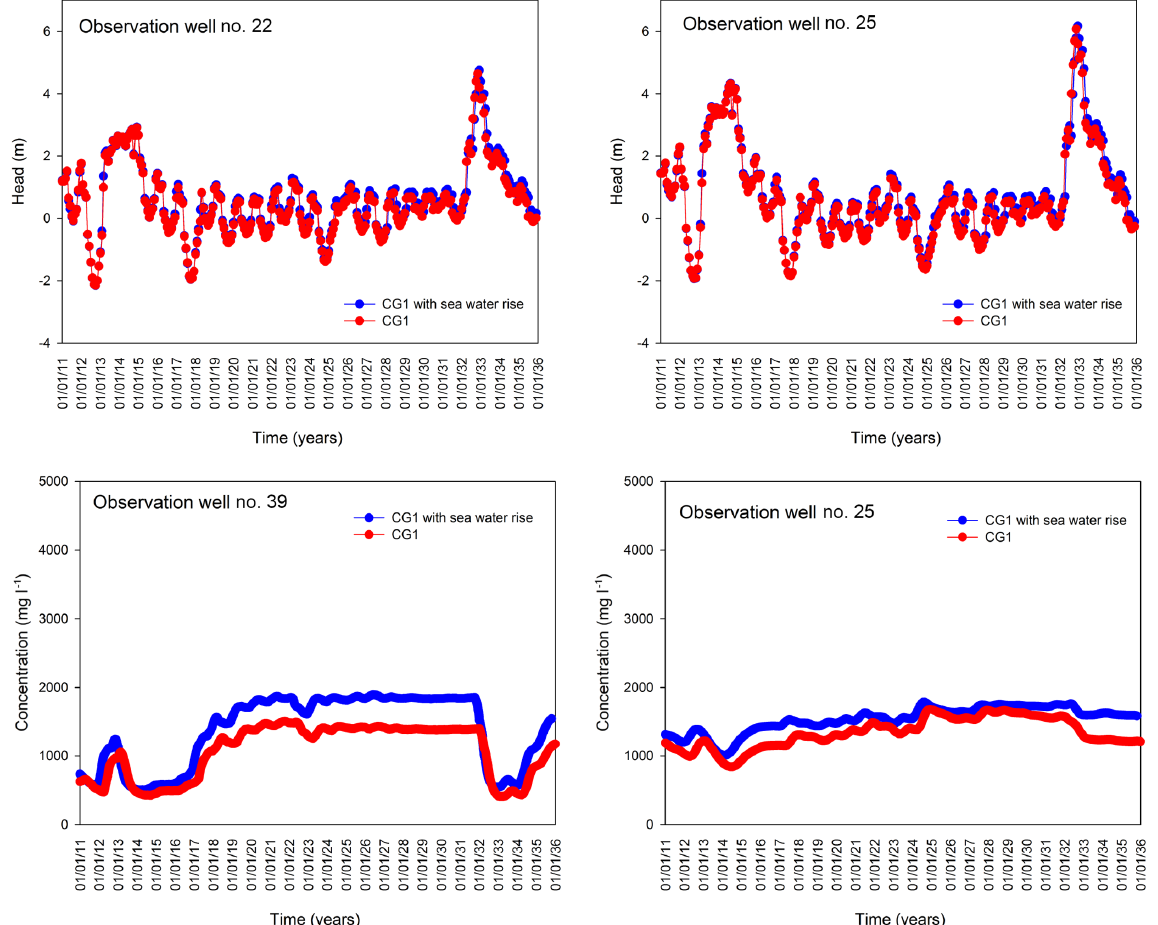
Figure 15. Sensitivity of head and salinity obtained for GC1 to a SLR (0.19m)